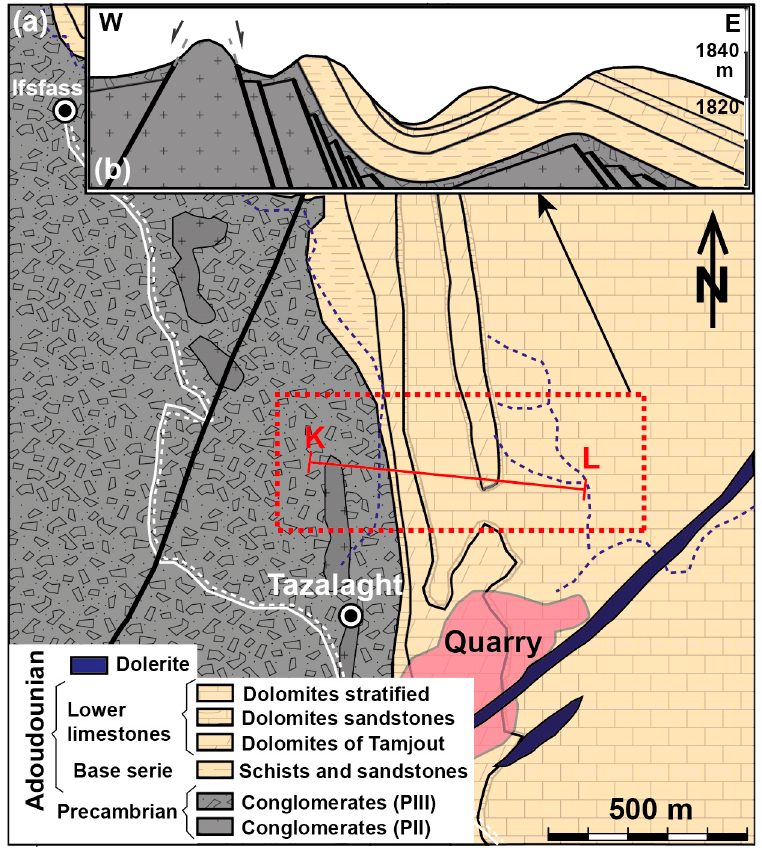
Figure 5. ( a ) Geological map. ( b ) Section K-L of the Tazalaght mining site (modified from El Basbas [20]). PII: Precambrian II. PIII: Precambrian III.